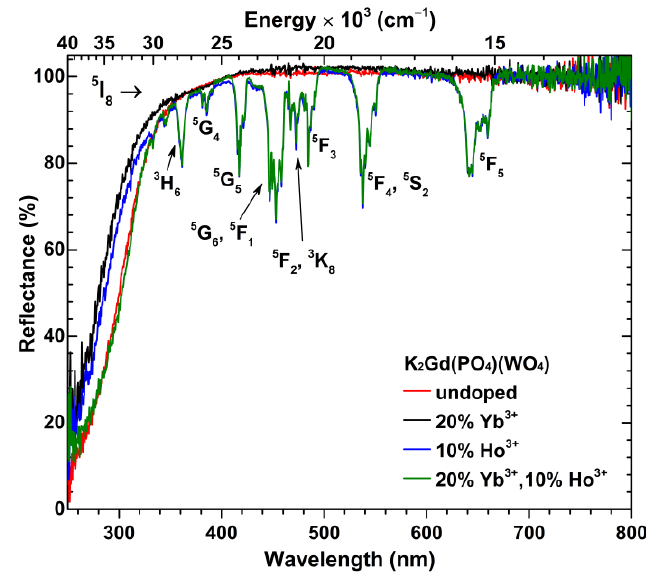
Figure 2. Reflectance spectra of K 2 Gd(PO 4 )(WO 4 ) (red line), K 2 Gd(PO 4 )(WO 4 ):20%Yb 3+ (black line), K 2 Gd(PO 4 )(WO 4 ):10%Ho 3+ (blue line), and K 2 Gd(PO 4 )(WO 4 ):20%Yb 3+ ,10%Ho 3+ (green line) speci- mens.